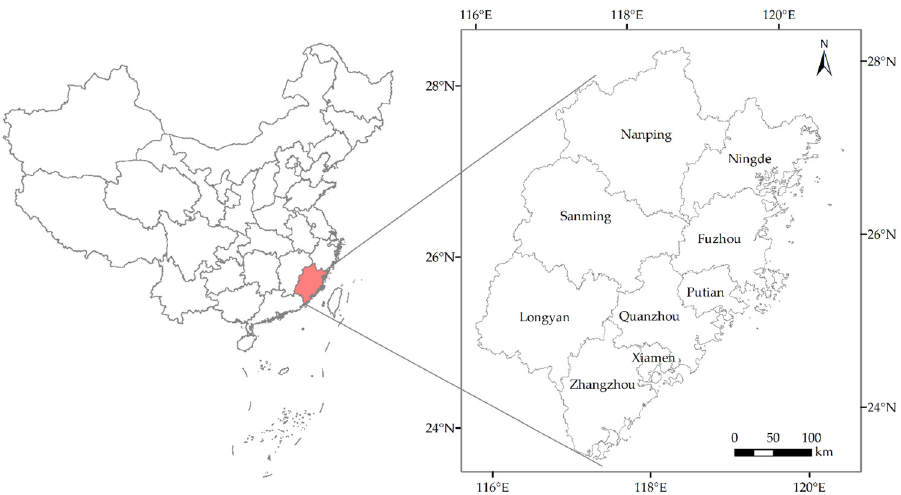
Figure 1. The location of the study area.